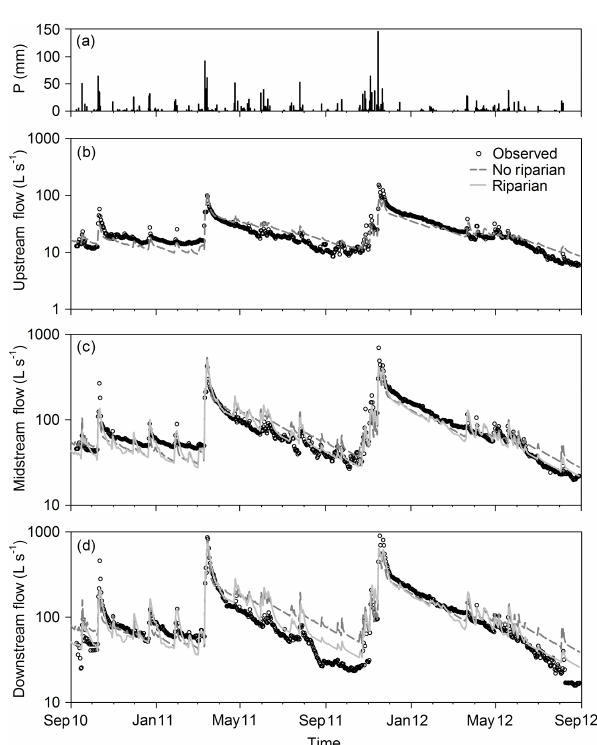
Figure 2. Temporal pattern of (a) precipitation and streamflow for the (b) upstream, (c) midstream, and (d) downstream sites during the study period. Open circles represent observed values, while lines are simulated values excluding (dashed) and including (solid) the riparian compartment in the model configuration. Note that the up- stream sub-catchment had no riparian forest, and therefore, simula- tions with and without the riparian zone are